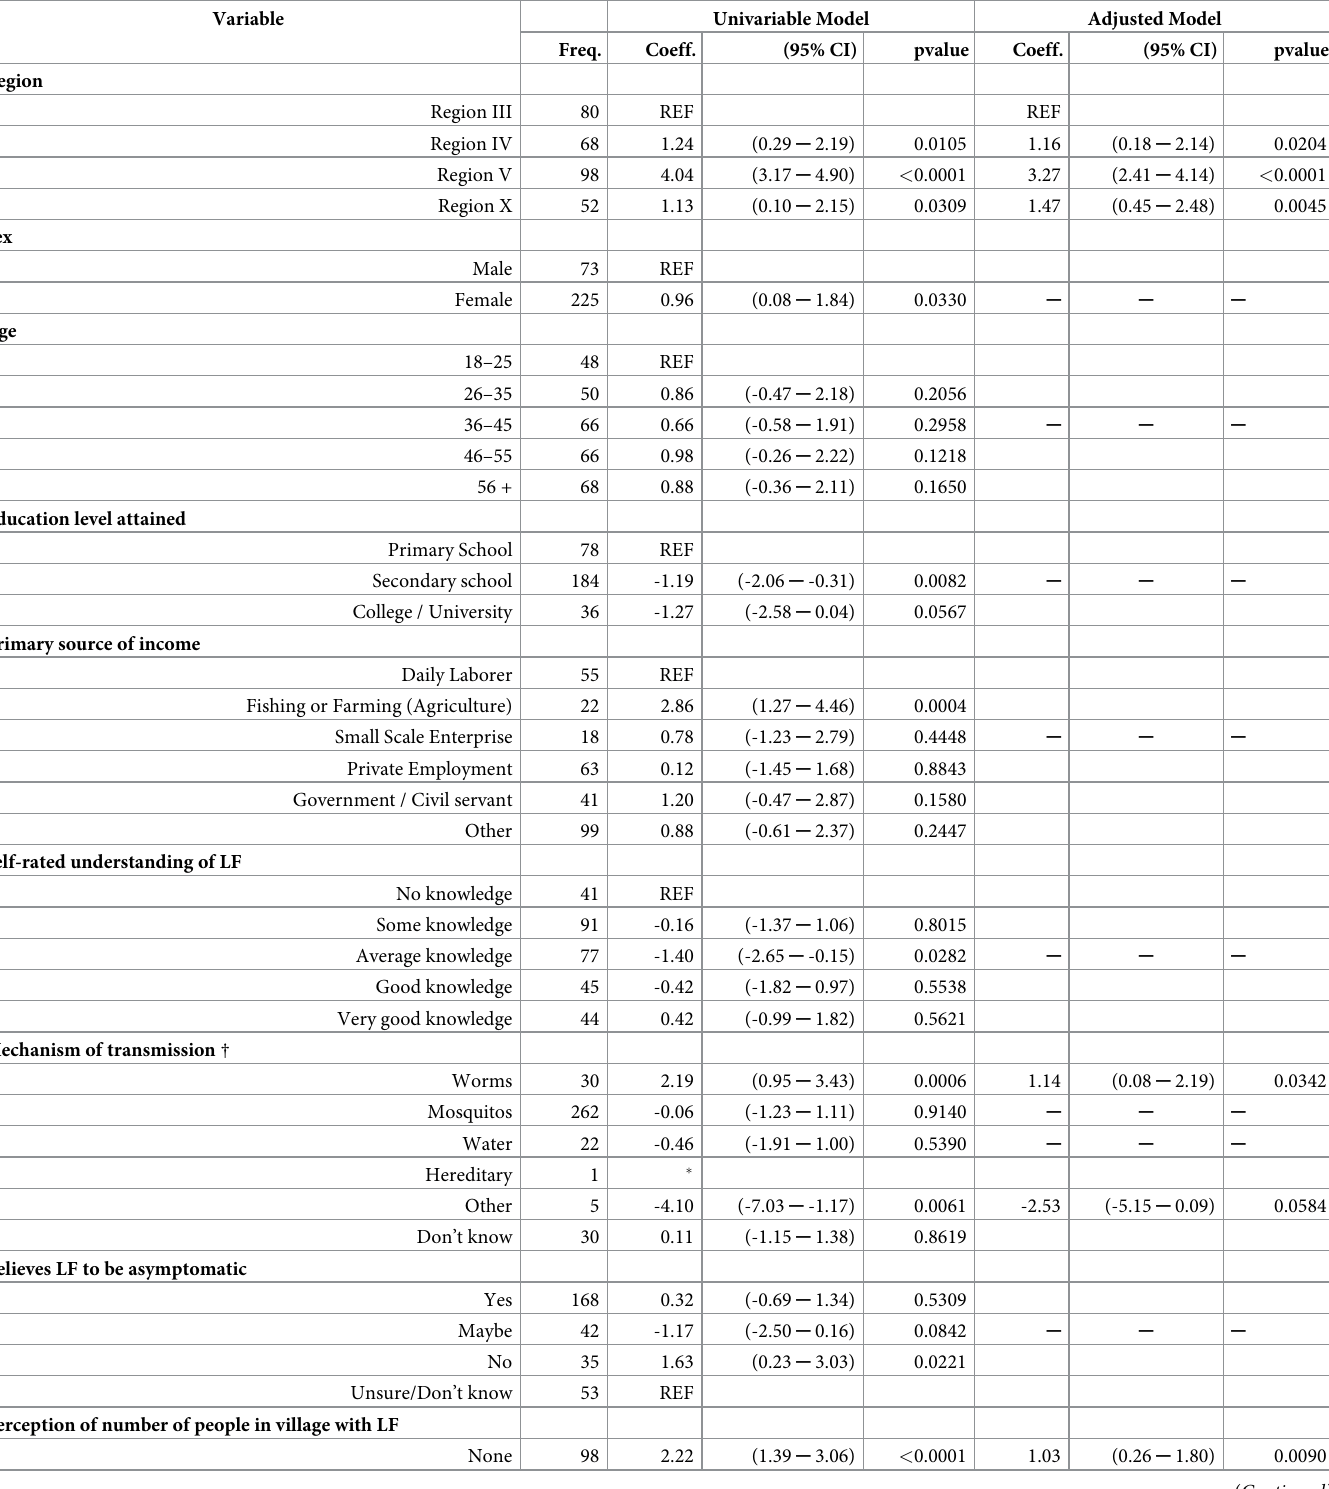
Table 8. Univariable and adjusted linear regression predicting composite acceptability score in a subset of the primary study population who have previously par- ticipated in an